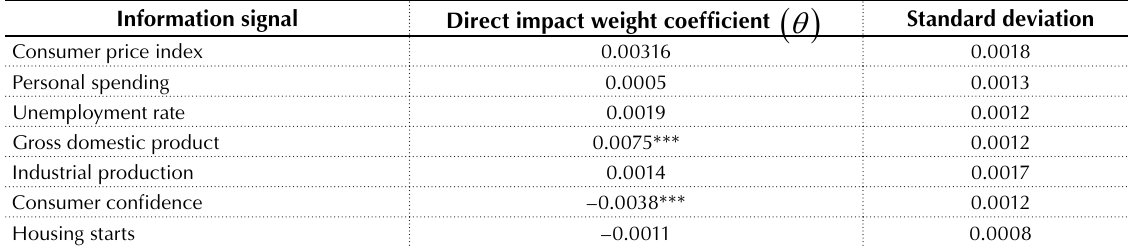
Table 13. The influence of the component of “surprise” on non-monetary information signals of the USA on the volatility of stock prices of enterprises of Ukraine in the economic sector “Industrials” Source: Compiled and calculated by the authors.